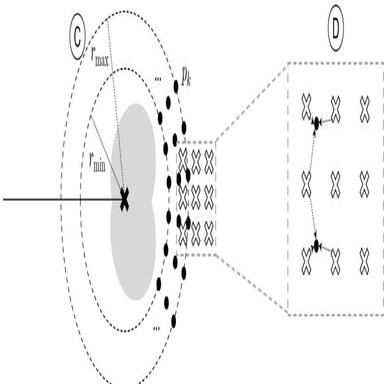
Convergence of 1 , … , 4 for various crack tip distances of integration paths, different mesh sizes e , and fixed number of integration points = 100.